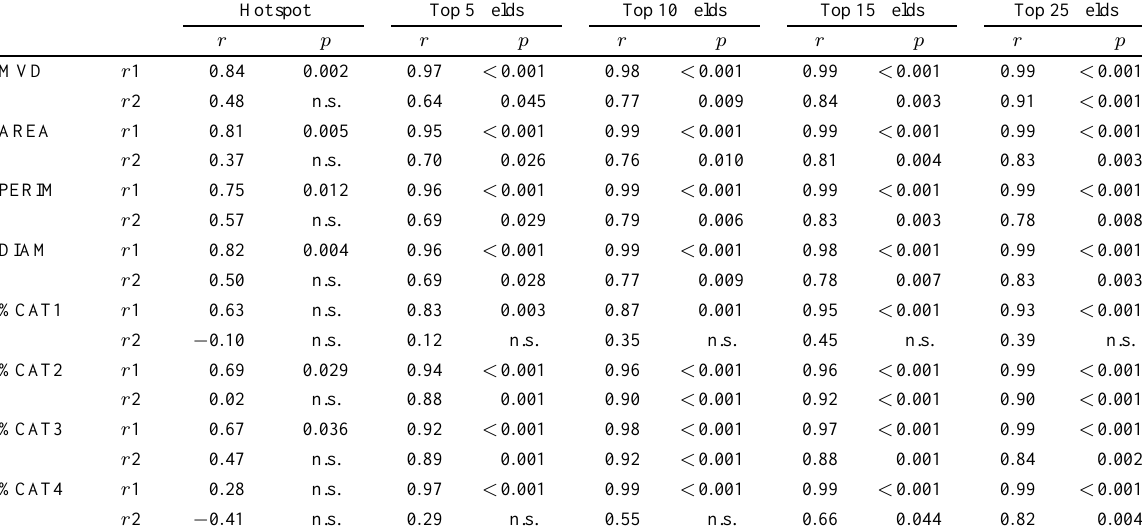
The interobserver correlations for the correction step ( r 1) and for the systematic sampling ( r 2) and their two-tailed p -values are given for the MVD and other parameters in the hot spot and averaged over the 5, 10, 15, and 25 highest vascularised fields, determined by systematic tissue sampling Hot